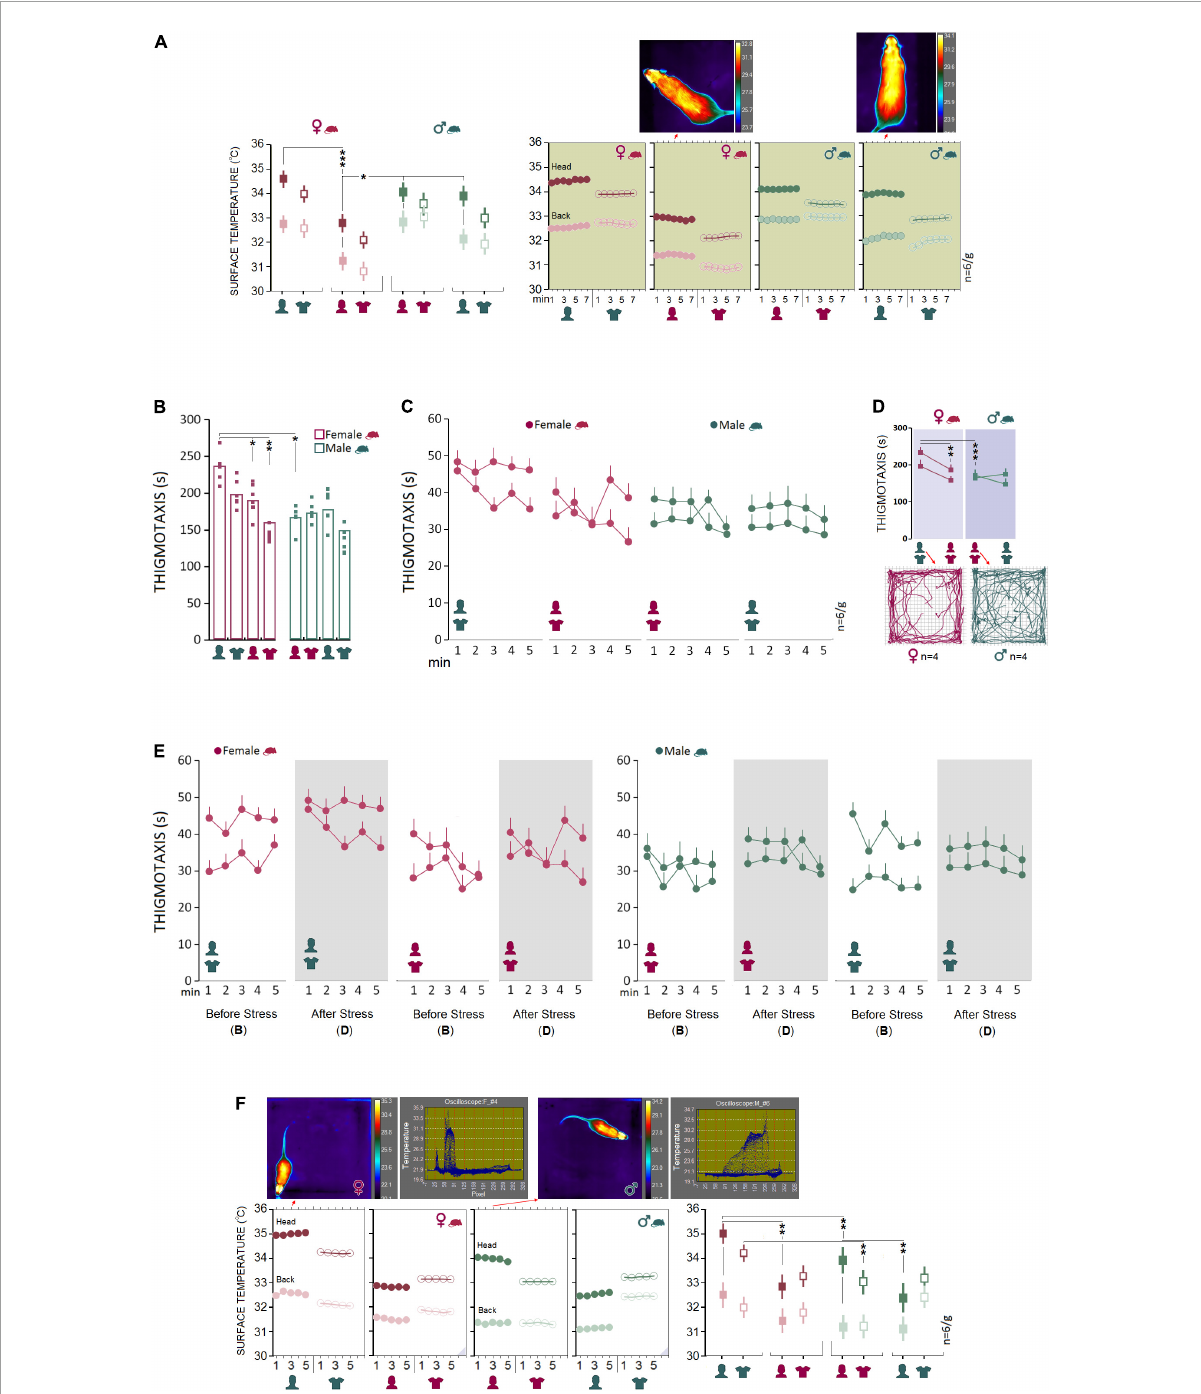
FIGURE3 Stress and post-stress open field exploration. (A) No significant difference was observed between females and males in the surface temperature when rats were stressed in the presence of opposite-sex experimenters or their T-shirts. Inset thermal graphics compare changes in cutaneous temperature in two representative rats in min 4. (B–D) Although thermal responses during stress in Experiment 1 showed no sex differences, post-stress thigmotaxis noticeably increased in females. The multipath taken from four representative rats in each group is shown in the inset motion track graphics. (E) A comparison of the pre- and post-stress thigmotaxis indicated females spent more times near to the wall than males at both time points in the presence of a male experimenter (left panel). (F) Interestingly, females displayed higher thermal changes than males in the head and back when exposed to a male experimenter and the male’s T-shirt (Exp1 and 2) after stress. The inset thermal graphics represent thermal changes in min 3 in a female and male rat accompanied by the pertinent oscilloscopes. Purple triangles in the panels represent D. IR recording (stress-open field). * p ≤ 0.05, ** p ≤ 0.01, *** p ≤ 0.001; one-way and repeated-measure ANOVA, n = 6/group. Error bars show ±